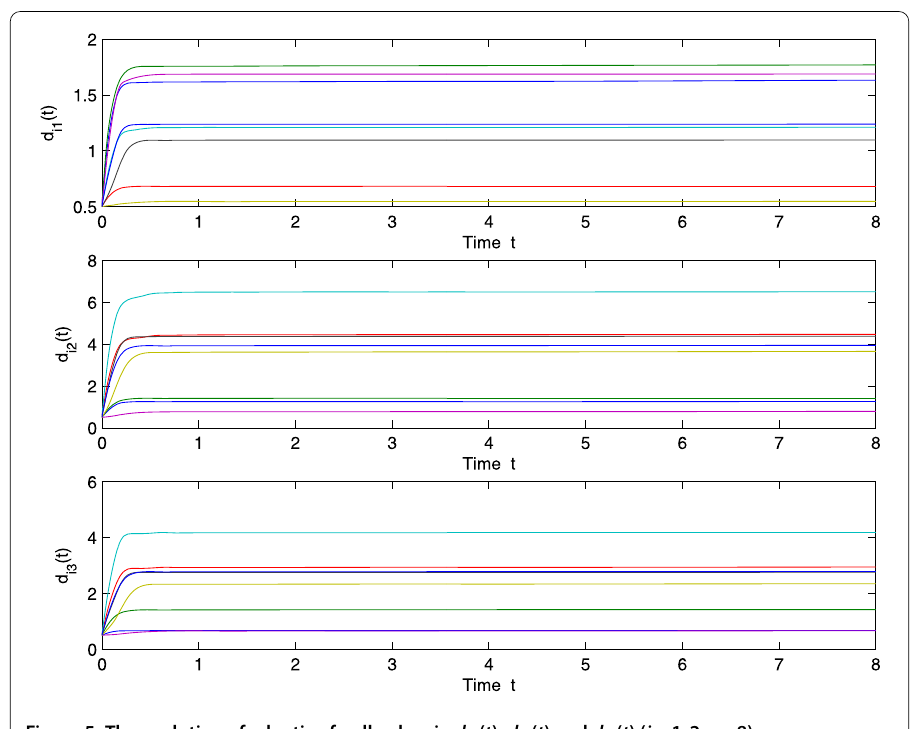
Figure 5 The evolution of adaptive feedback gain d i 1 ( t ), d i 2 ( t ) and d i 3 ( t ) ( i = 1,2,...,8).